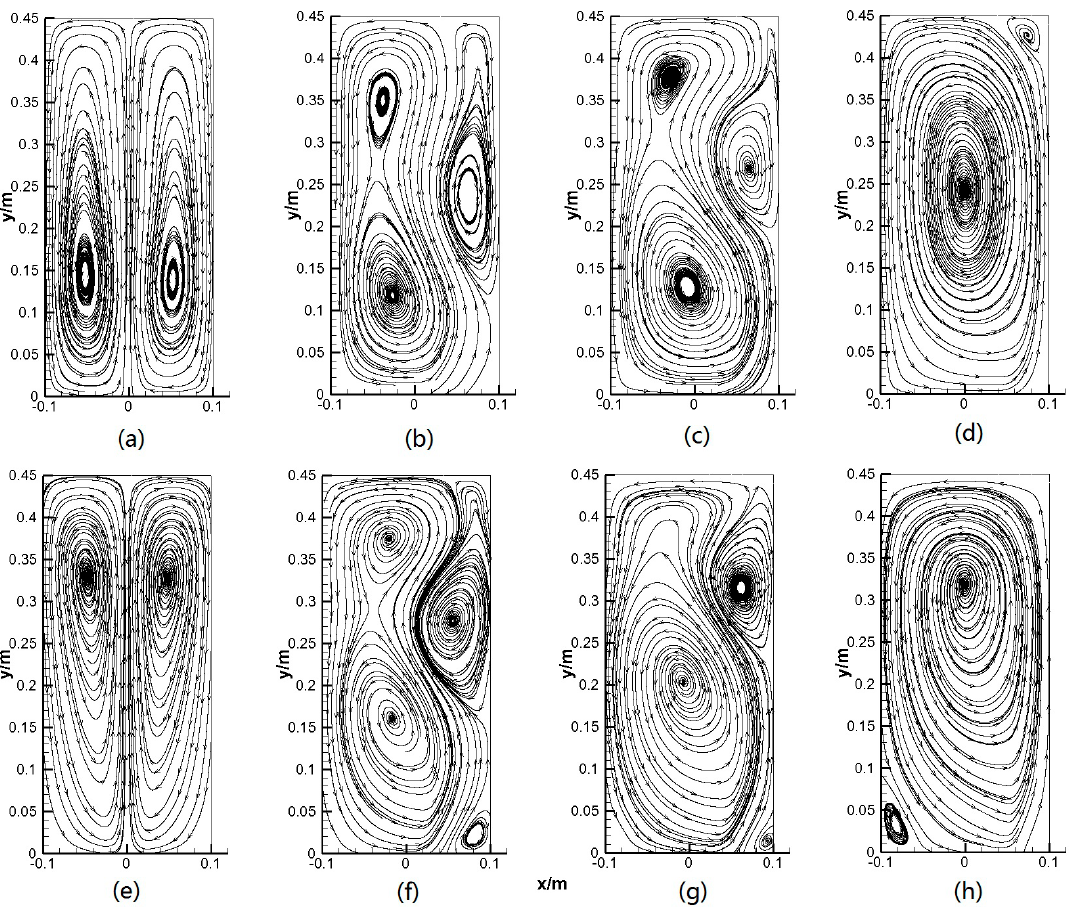
Figure 6. Time-averaged streamline at z = 0 m in the bubble column: ( a ) case 1 (NEW-0), ( b ) case 2 (NEW-0.025), ( c ) case 3 (NEW-0.045), ( d ) case 4 (NEW-0.06), ( e ) case 5 (NON-0), ( f ) case 6 (NON-0.025), ( g ) case 7 (NON-0.045), and ( h ) case 8 (NON-0.06).